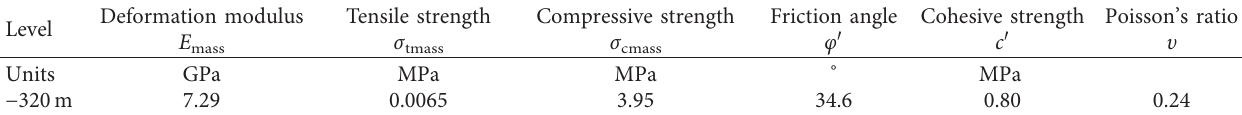
Table 4: The mechanics parameters of weak rock drift.